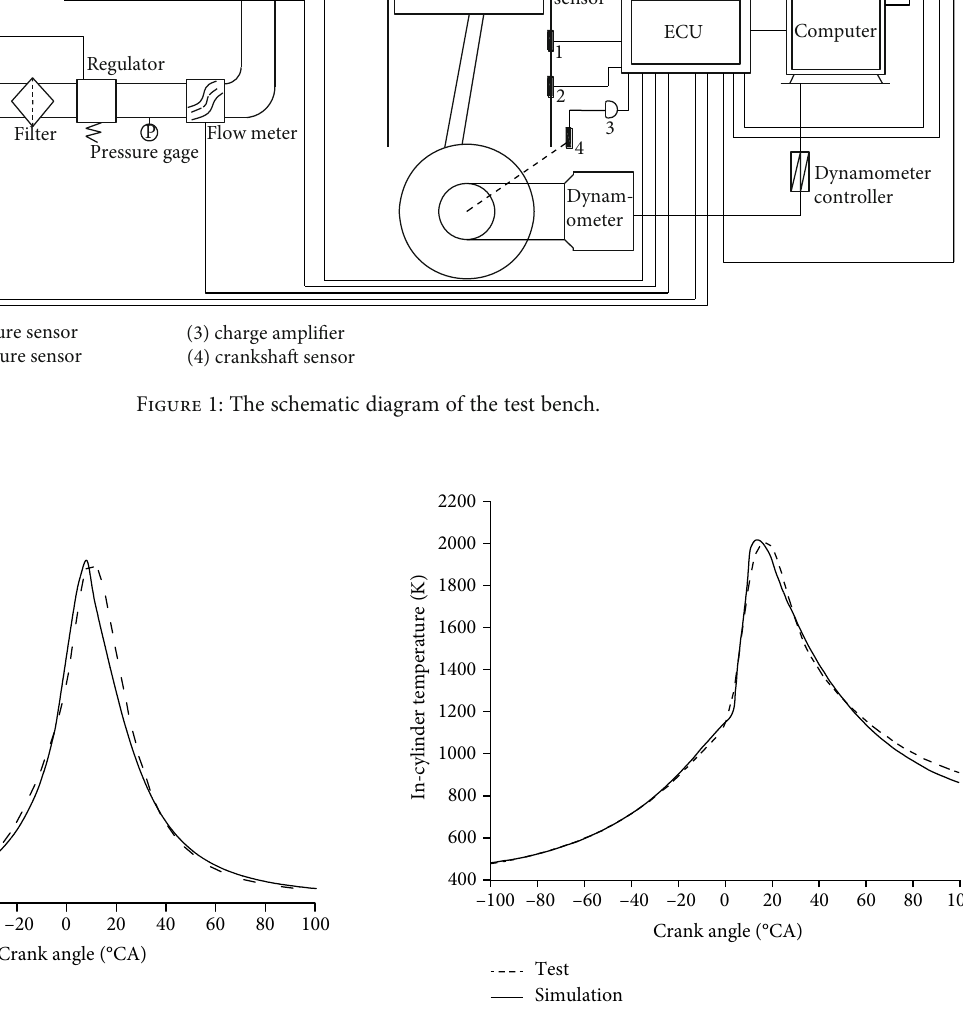
Figure 2: Comparison between simulated and measured pressure.